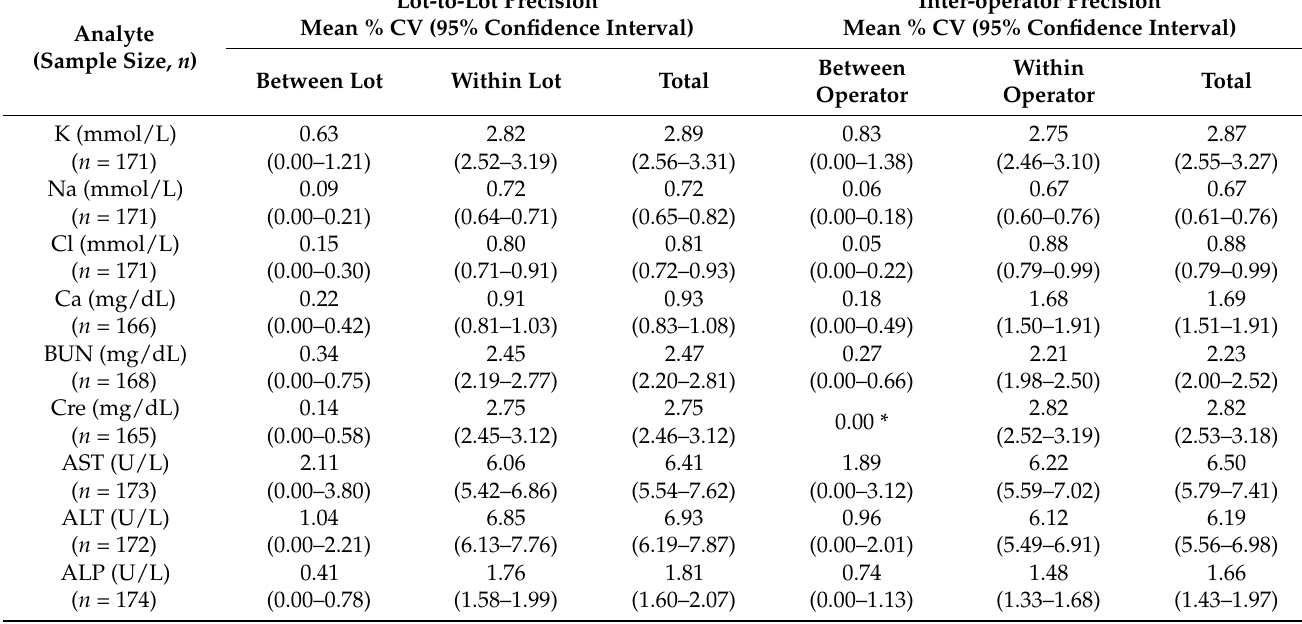
Table 3. Total percent (%) CV and components of variance between lot/operator and within lot/operator across all the sites. K: Potassium; Na: Sodium; Cl: Chloride; Ca: Calcium; BUN: Blood Urea Nitrogen; Cre: Creatinine; AST: Aspartate Aminotransferase; ALT: Alanine Aminotransferase; ALP: Alkaline Phosphatase; T.Bili: Total Bilirubin; Alb: Albumin; TP: Total Protein; Chol: Cholesterol; TRIG: Triglycerides. Note that 0.00 * is negative ANOVA-type estimated CVs which were set to 0.00, and which did not contribute to the total